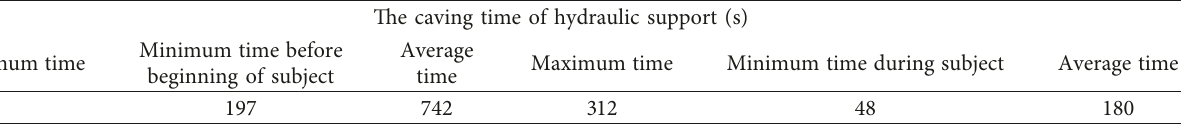
Figure 24: Longitudinal resistance distribution of working face during pressure period and nonpressure period. Table 10: Statistics on the caving time.